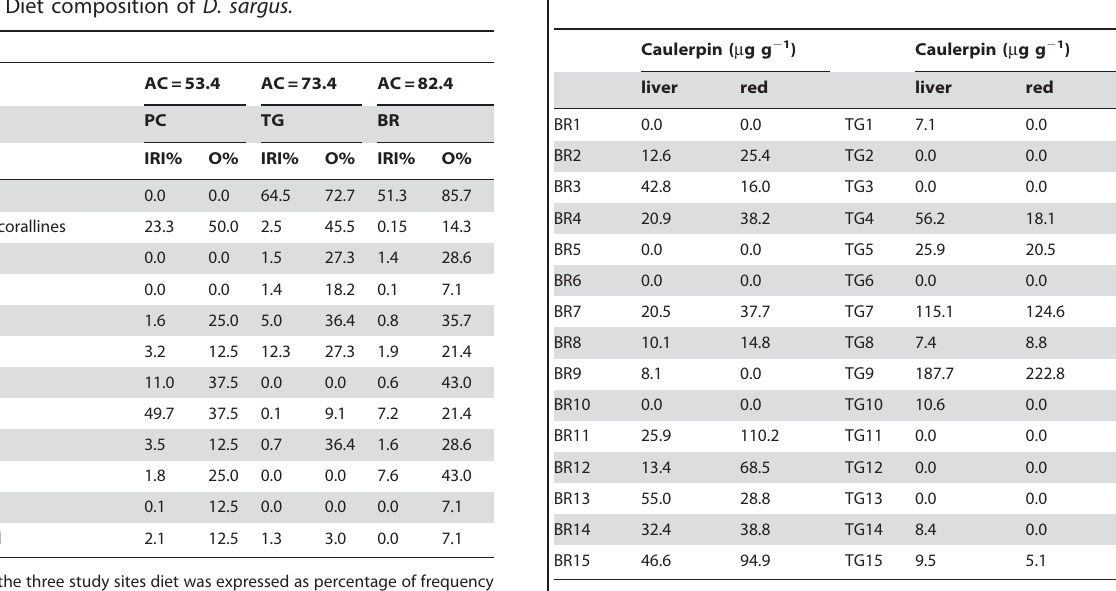
Table 2. Concentrations of caulerpin in liver and red muscle of fish from BR and